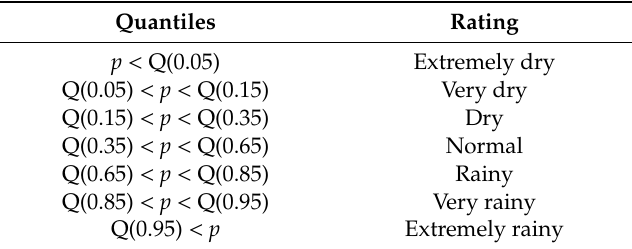
Table 2. Corresponding range to climate classifications represented by their